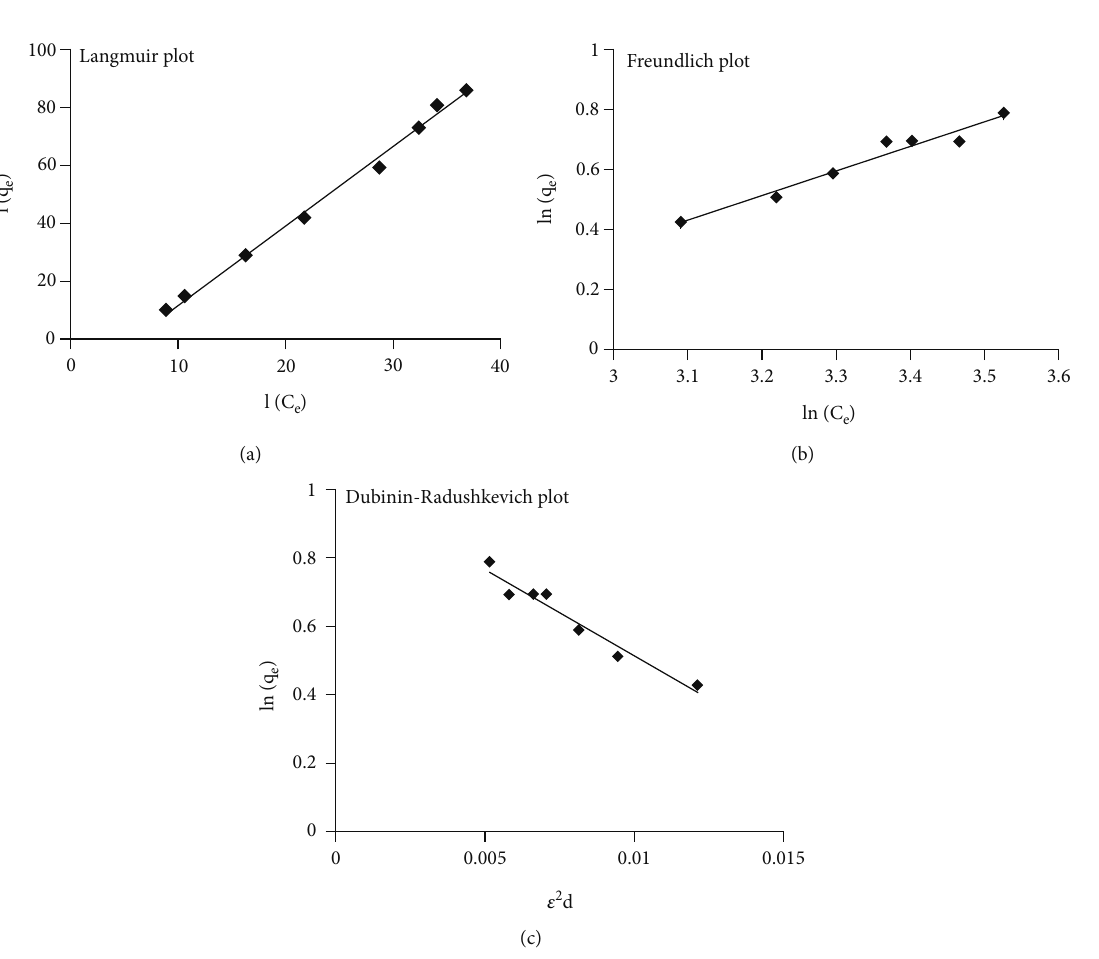
Figure 5: Equilibrium model plots of biochar-Congo red dye adsorption system: (a) Langmuir plot; (b) Freundlich plot; (c) Dubinin – Radushkevich plot. Table 7: Calculated various equilibrium model parameters for adsorption of Congo red dye on breadfruit leaf biochar adsorbent.